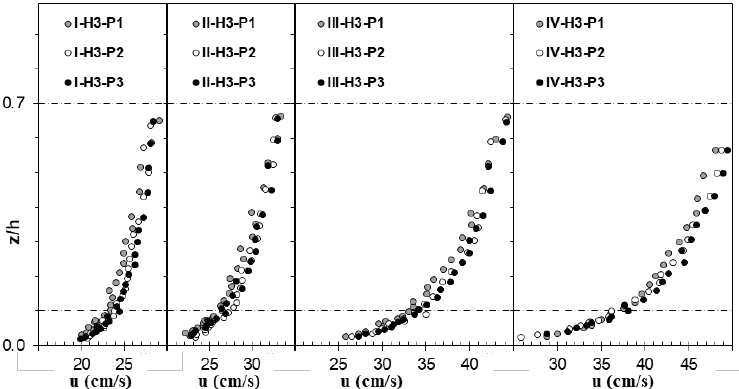
Figure 3. Flow velocity profiles at cross sections P1, P2, and P3 within the study reach (cm/s). The velocity verticals were acquired using the ADV along this 4 m long sand-bed flume section. As shown in Figure 4, the upstream and downstream of the study sand- bed reach were covered by coarse particles that were not mobilized during experimental runs. The coarse-grained material upstream of the sand-bed facilitates a fully turbulent flow condition. In order to eliminate the effect of the bed roughness change on flow characteristics, the first (P1) and the last (P3) positions were located at a distance of one meter from the course materials. The position of P2 was located between P1 and P3, namely, in the middle of the study sand bed.